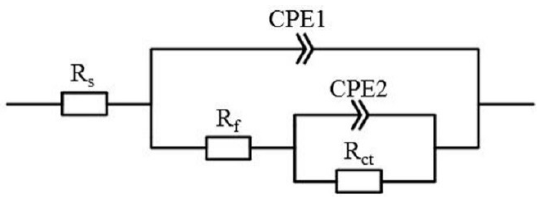
Figure 2. Equivalent circuits used to fit the conduction curve in the impedance spectrum analysis.